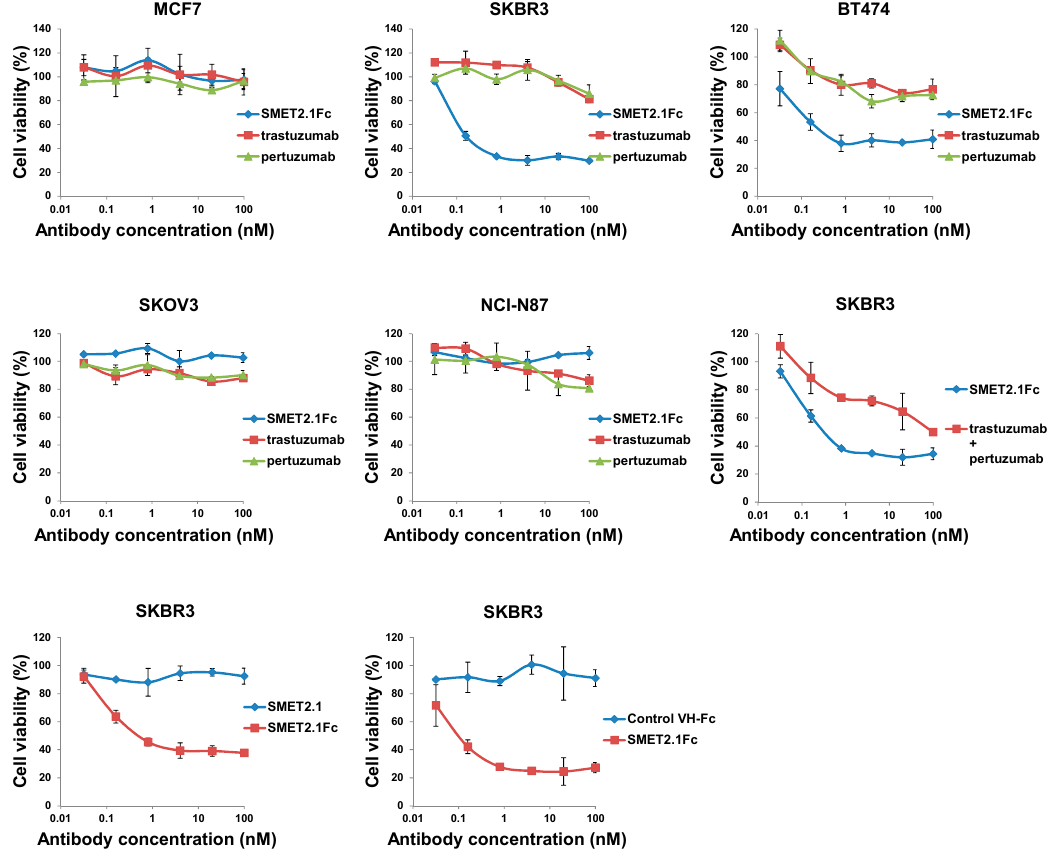
Figure 4. Growth inhibition of HER2-expressing human cancer cell lines in cell cultures. Trastuzumab and pertuzumab used in this experiment are full-length IgG1 antibodies. The assay was performed in duplicate. Results are the mean ± standard deviation.